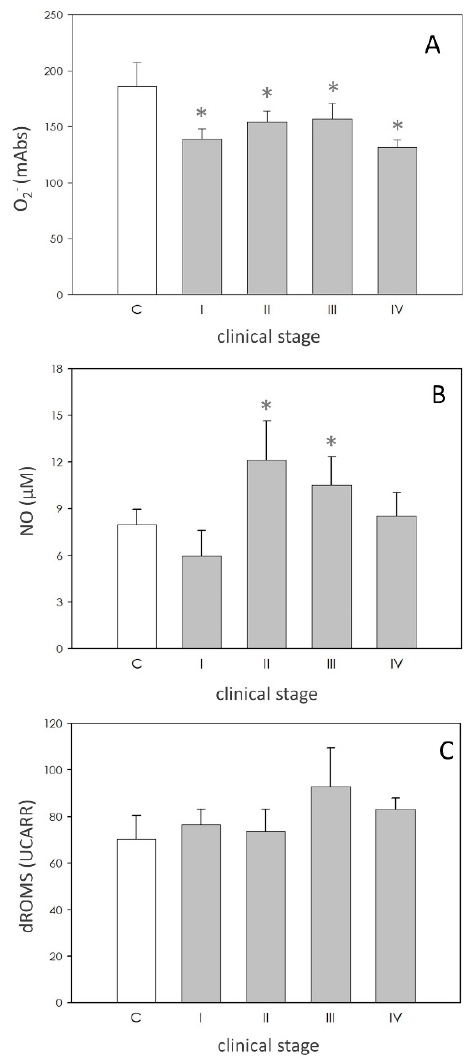
Figure 1. Reactive oxygen species (ROS) and reactive nitrogen species (RNS). Panel ( A ): superoxide anion (O 2 − ) levels expressed as milliabsorbance units (mAbs). Panel ( B ): nitic oxide (NO) expressed as µ M. Panel ( C ): hydroperoxide levels expressed as Carratelli Units (UCARR). In each panel, asterisk (*) on the bar indicate significant difference ( p < 0.05) as assessed by ANOVA and Scheff è F